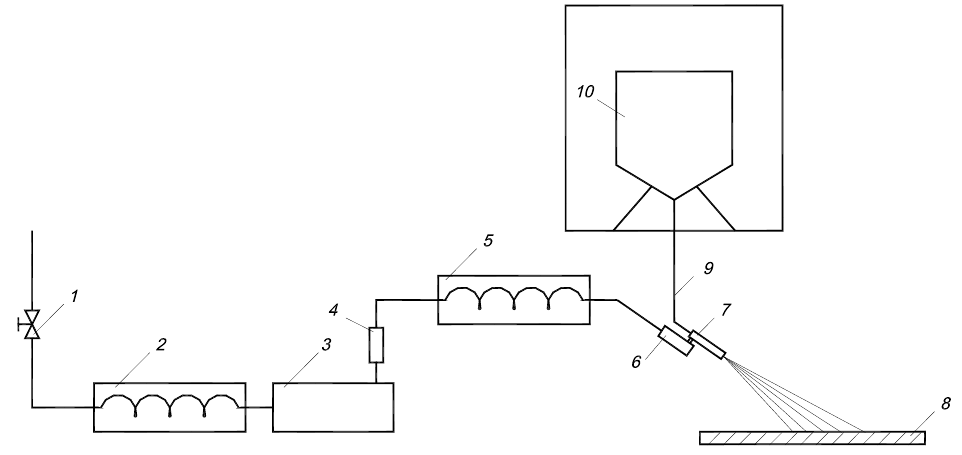
Figure 1. Scheme of the experimental system: 1—valve, 2—radiator, 3—water pump, 4—control system, 5—radiator, 6—high-pressure gun, 7—sprinkler, 8—work surface, 9—suction hose, 10—CO 2 dry ice particle tank.